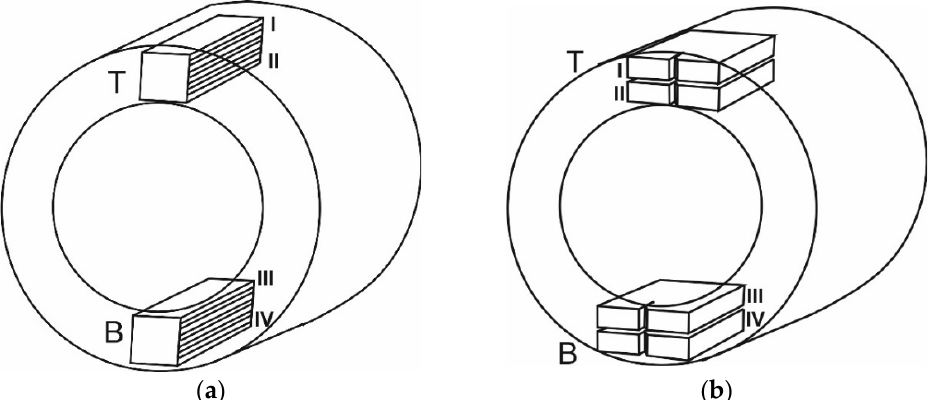
Figure 1. Schemes of cutting specimens from pipes for ( a ) the metallographic analysis of steel and ( b ) FCG resistance (mechanical) tests. Zones of cutting specimens from the upper (referred to as T) and lower (B) parts of the pipe in the positions close to its outer (zones I and IV) and inner (zones II and III) surfaces are marked.